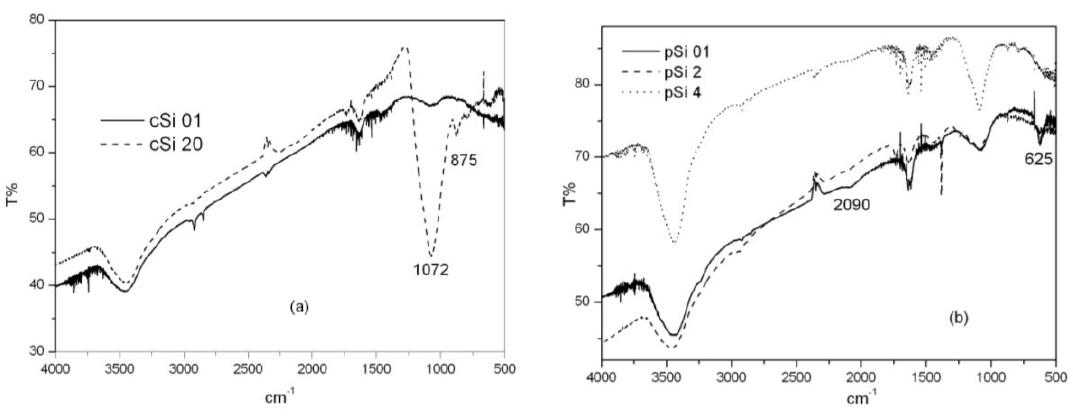
Figure 3. Fourier-transform infrared spectroscopy (FT-IR) spectra for the crystalline samples: ( a ) milled at 0.1 h and 20 h; ( b ) porous samples milled at 0.1 h, 2 h and 4